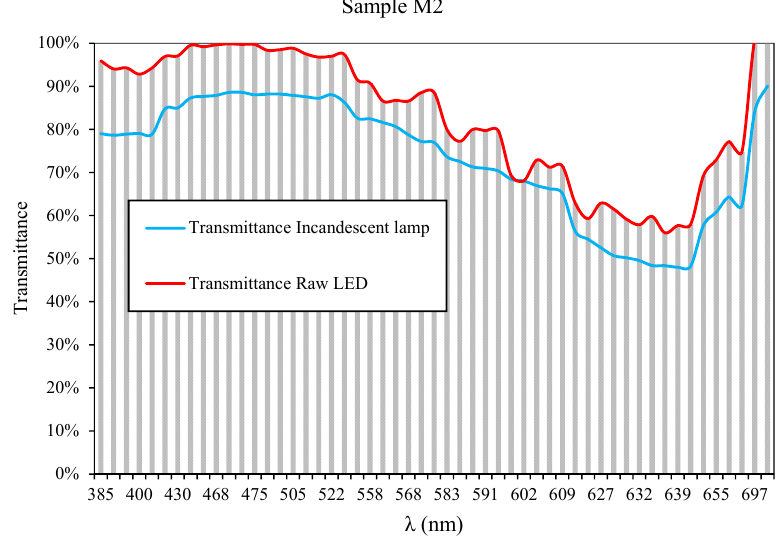
Figure 7. Comparison of the transmittance values obtained by a 5 mm LEDs spectral and those obtained by means of the commercial equipment.